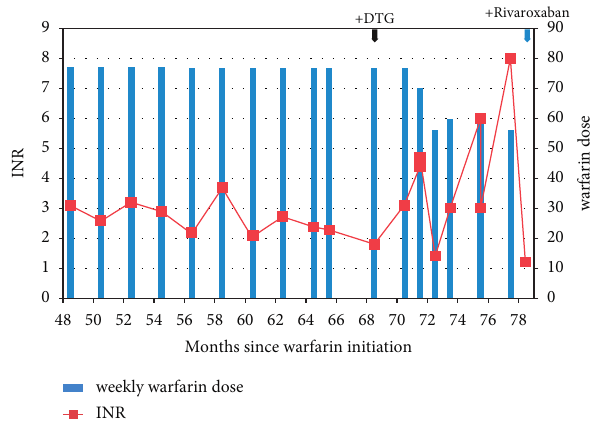
Figure 2: Graphical representation of case 2’s INR and corre- sponding weekly warfarin dose during clinical visits.